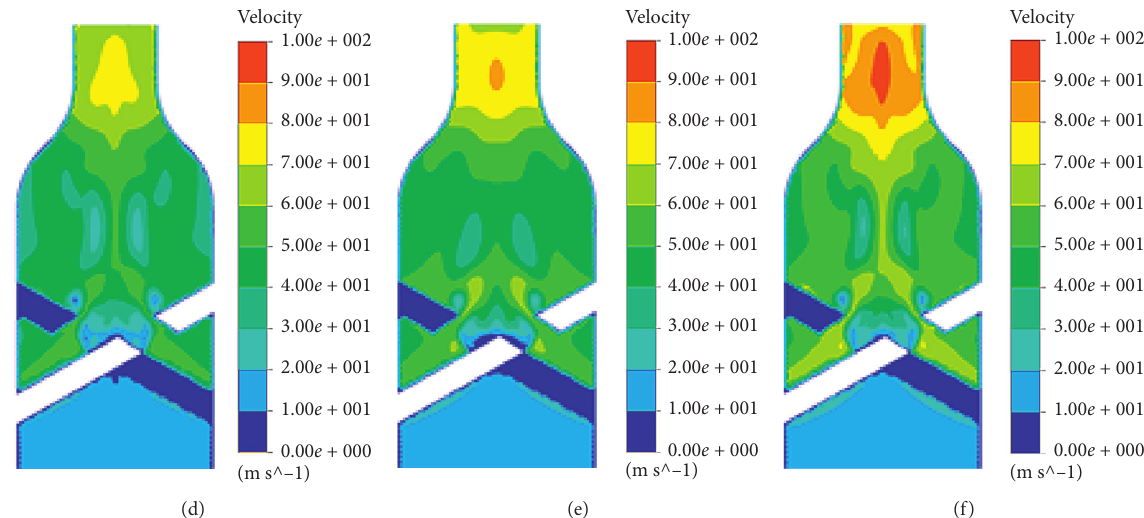
Figure 5: Velocity distribution in the center section of the swirl nozzle: (a) 1MPa, (b) 2 MPa, (c) 3 MPa, (d) 4MPa, (e) 5MPa, and (f) 6MPa.